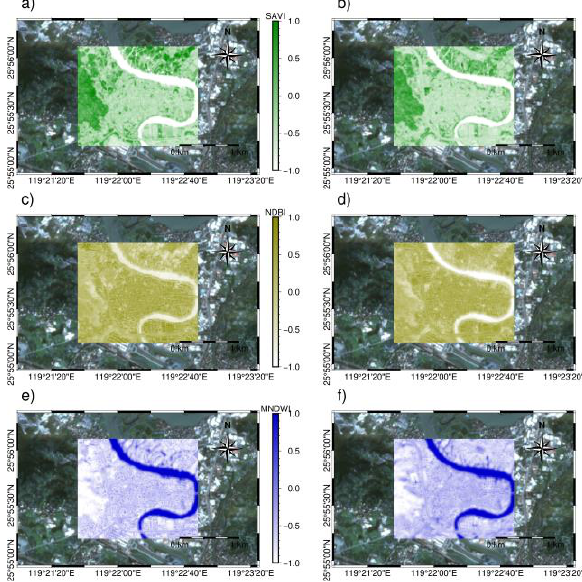
Jan. 2022 Figure 9 . The SAVI, NDBI and MNDWI values of area D at January 2016 and January